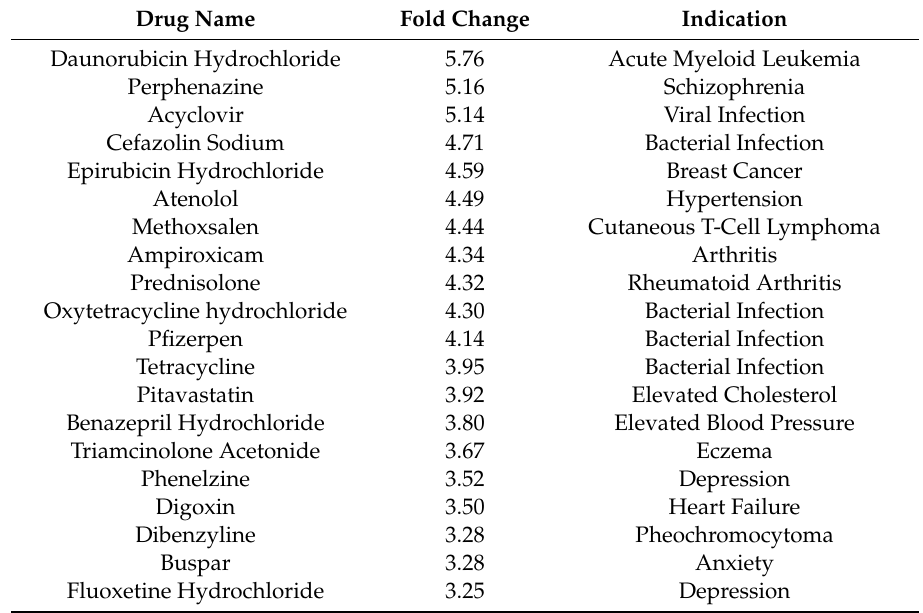
Table 2. Top 20 FDA-approved drugs that positively modulate HbF in iRBCs (CD45 + cells derived from sickle-cell patients that have been in vitro di ff erentiated towards an erythroid